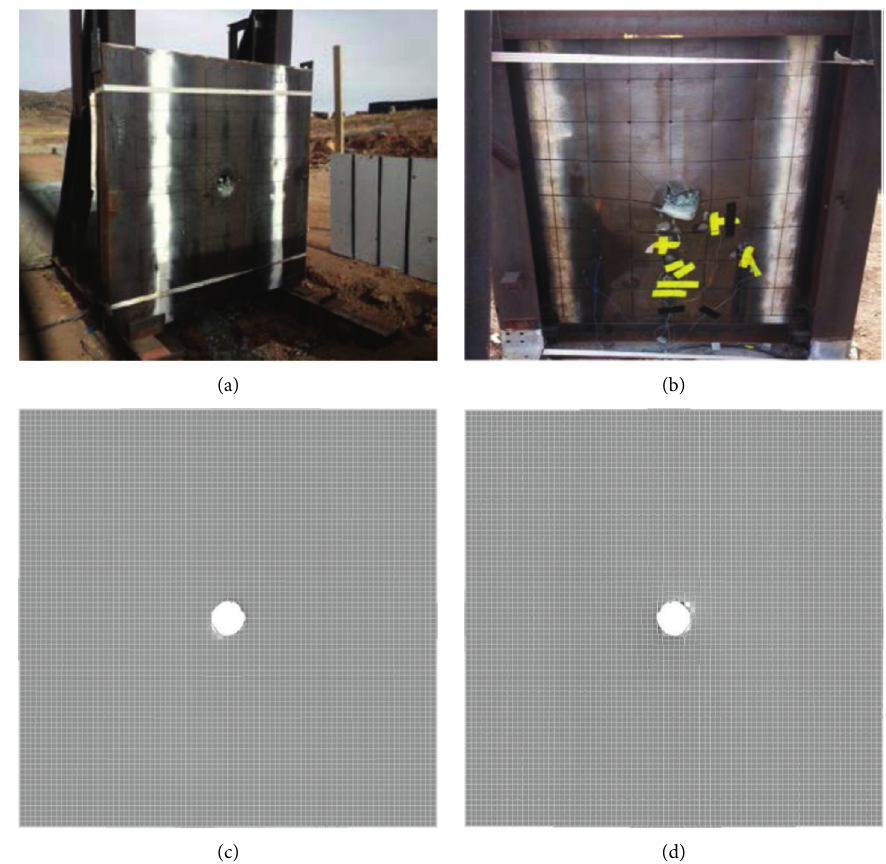
Figure 3: Comparison of SCS wall response (SCS-175-6T). (a) Front steel plate of test. (b) Rear steel plate of test. (c) Front steel plate of FEM simulation. (d) Rear steel plate of FEM